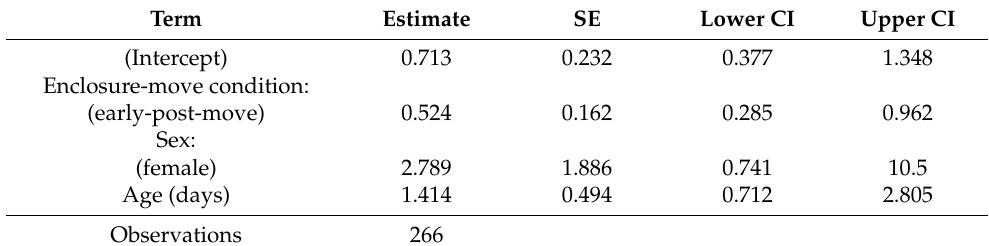
Table A12. Model 7 summary output: Effect of enclosure move on Malayan sun bear visibility.